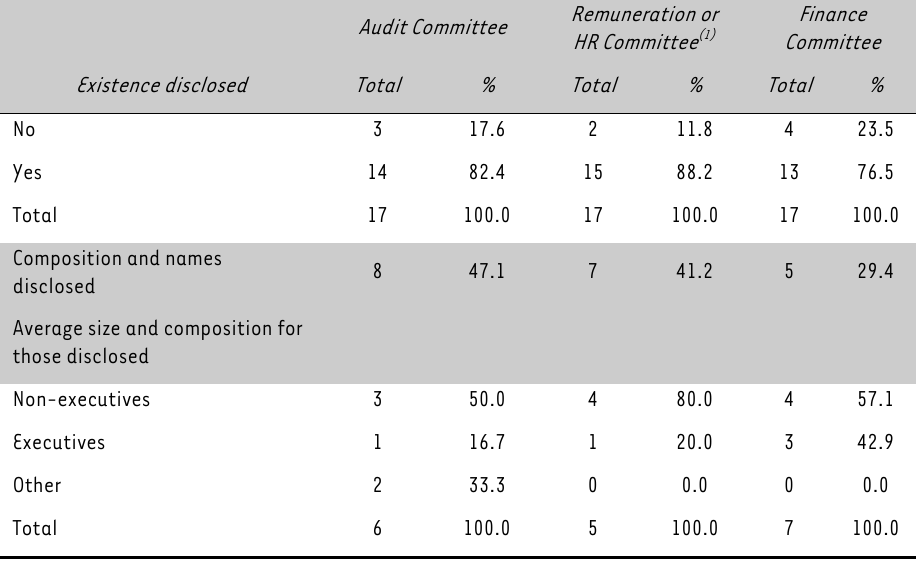
TABLE 4: Committee